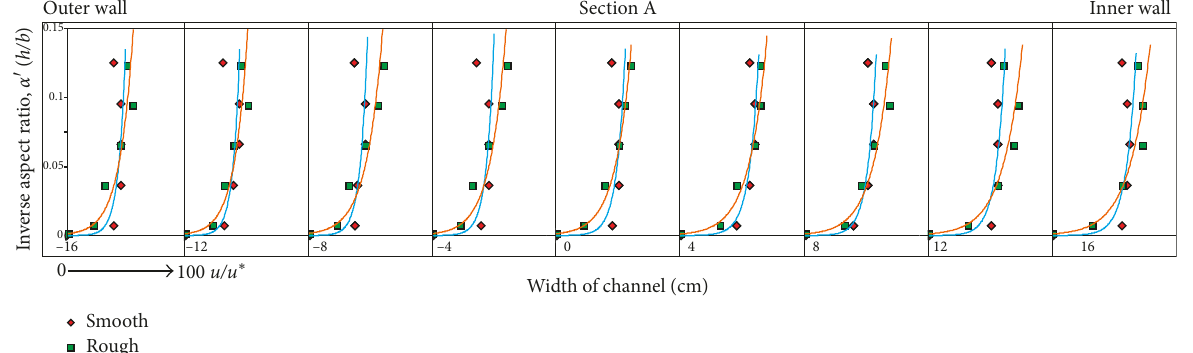
Figure 4: Comparison of velocity variation in section A.